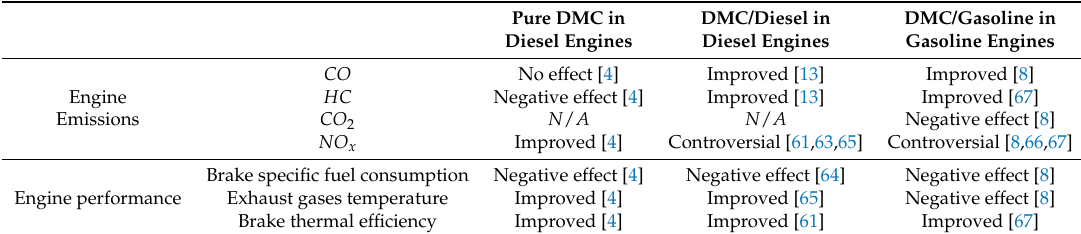
Table 2. Summary of the effect of DMC on IC engines pollutants and